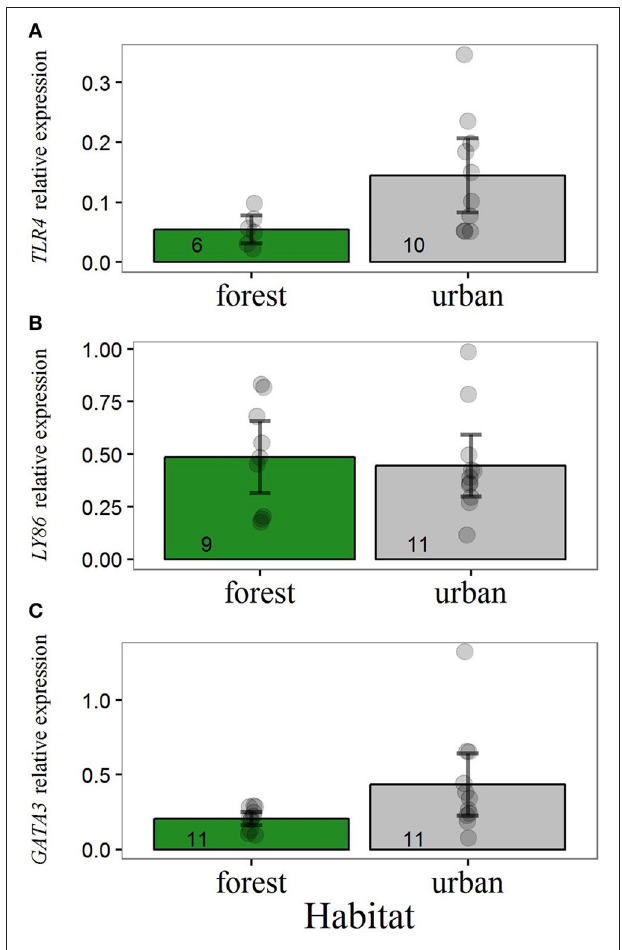
FIGURE 1 | Relative expression of (A) TLR4 , (B) LY86 , and (C) GATA3 for adult, breeding blue tits. Y-axis values refer to levels of gene expression relative to the expression of reference genes. Main bars illustrate raw data mean values and dark error bars illustrate ± 2 standard errors. Dots represent raw data points. Sample sizes are illustrated at the base of each bar.